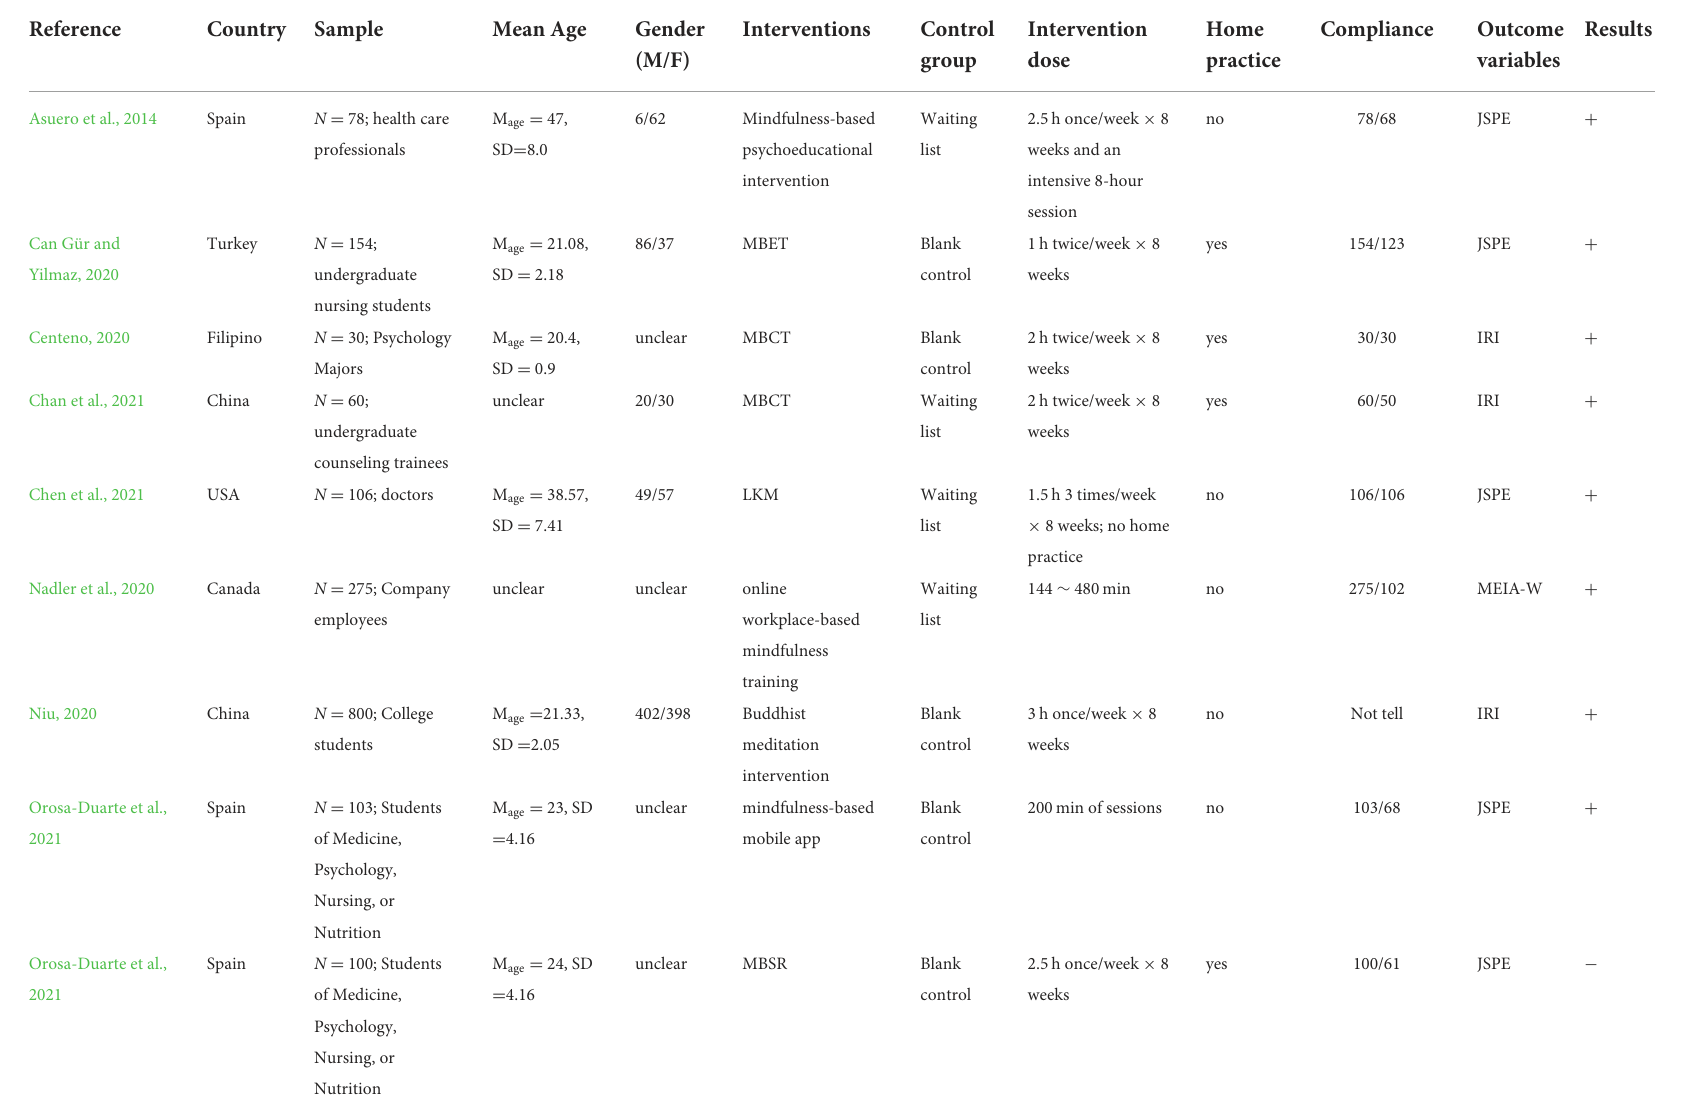
TABLE 1 Characteristics of the included